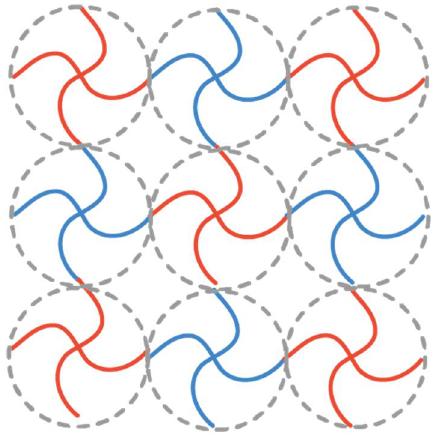
Figure 1. Schematic illustration of polymer networks prepared by mutual reactive tetra-functional poly(ethylene glycol)s (PEG) macromonomers (4 × 4 gels). Blue and red polymer refer to the tetra-functional PEG macromonomers with different end-groups.